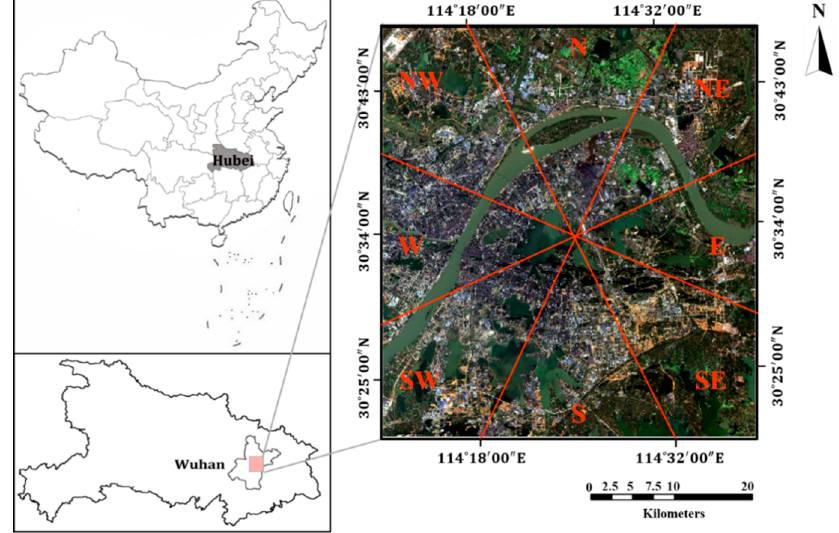
Figure 1. The geographical location and eight sub-regions of the study area and corresponding RGB Landsat-8 OLI image (October 24th 2017).